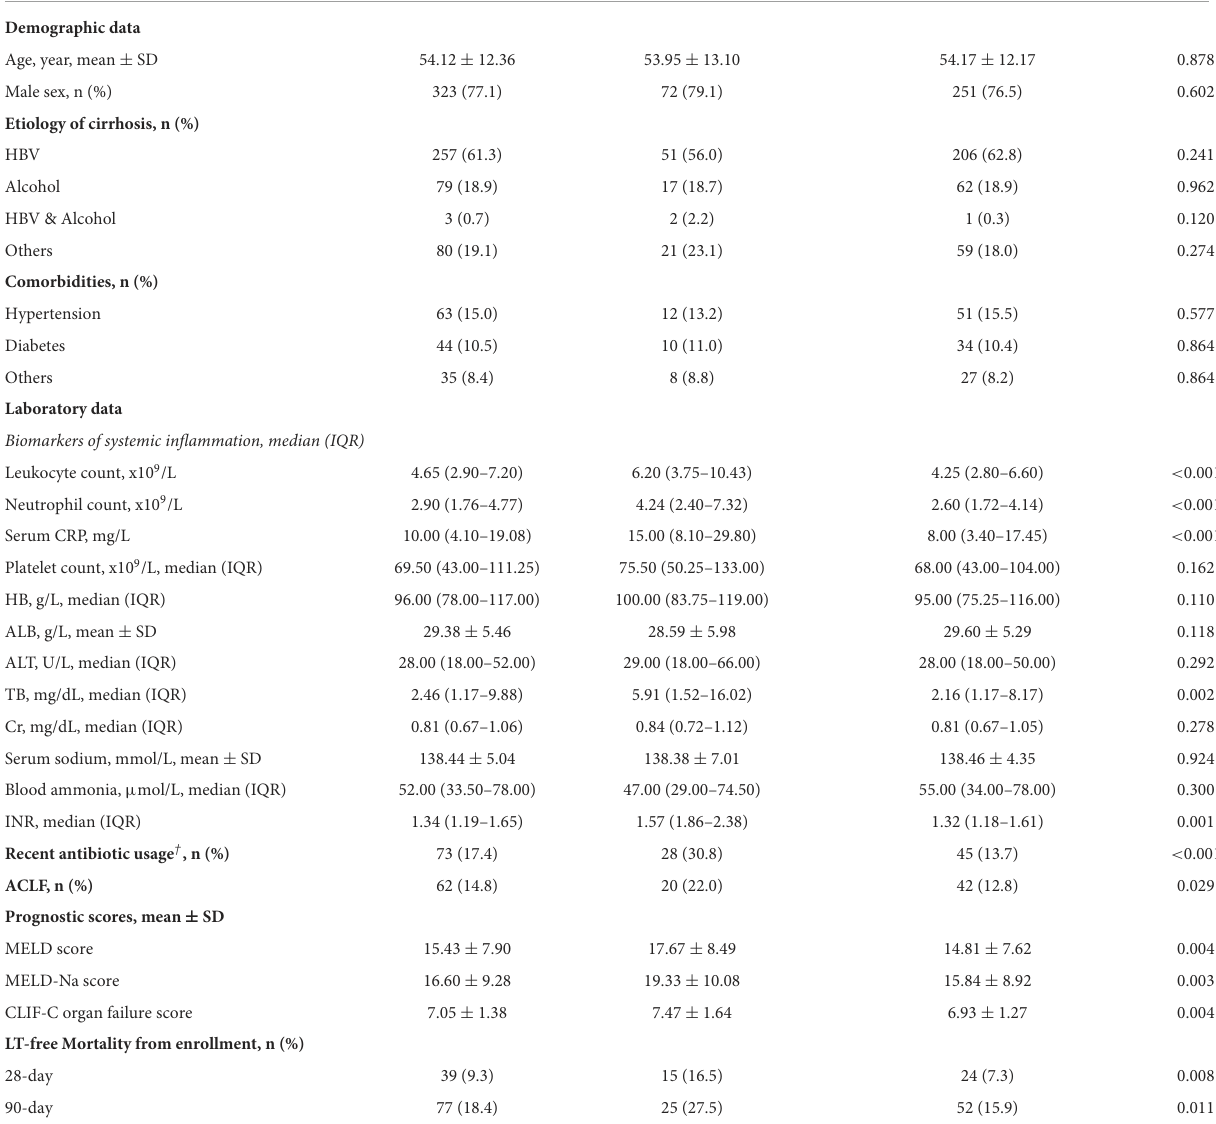
TABLE 1 Baseline characteristics of the enrolled patients with and without